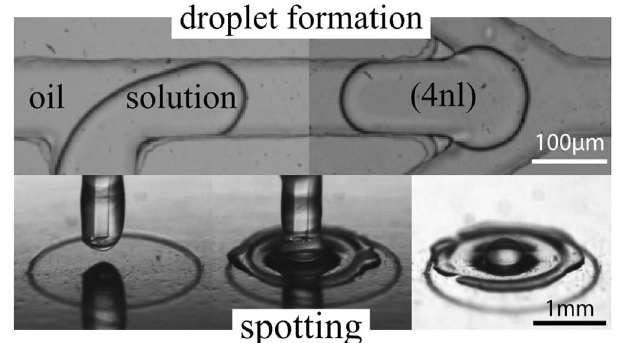
Figure 1. DMF-MALDI Set-up: droplet creation and spotting. Top: droplet generation (left), droplet spacing (right) within the PDMS microfluidic chip. Bottom: before deposition (left), during deposition (middle), after deposition (right) on stainless steel MALDI